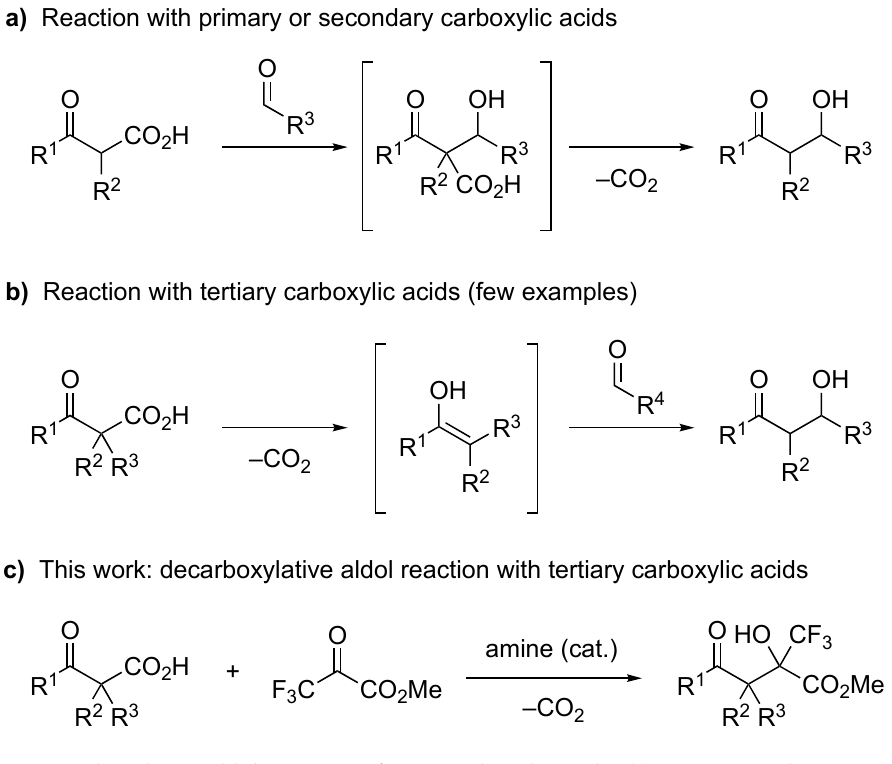
Table 1. Optimization of the amine catalyst 1 .